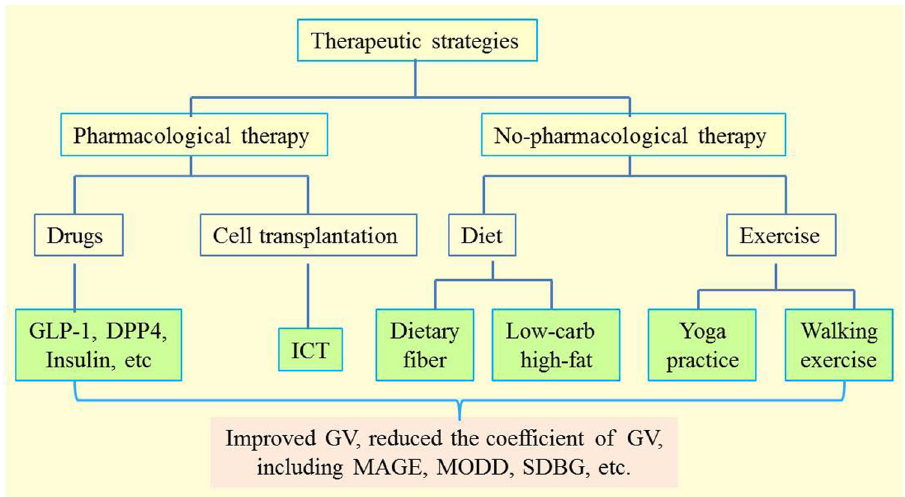
Fig. 2 Therapeutic strategies to improve GV. Pharmacological therapy including drugs and insulin as well as non-pharmacological therapy including diet, cell transplantation, and exercise are recommended to improve GV. MAGE mean amplitude of glycemic excursion, MODD mean of daily differences, GLP-1 glucagon-like peptide-1, DPP4 dipeptidyl peptidase 4, ICT islet cell transplantation, SDBG standard deviation of blood